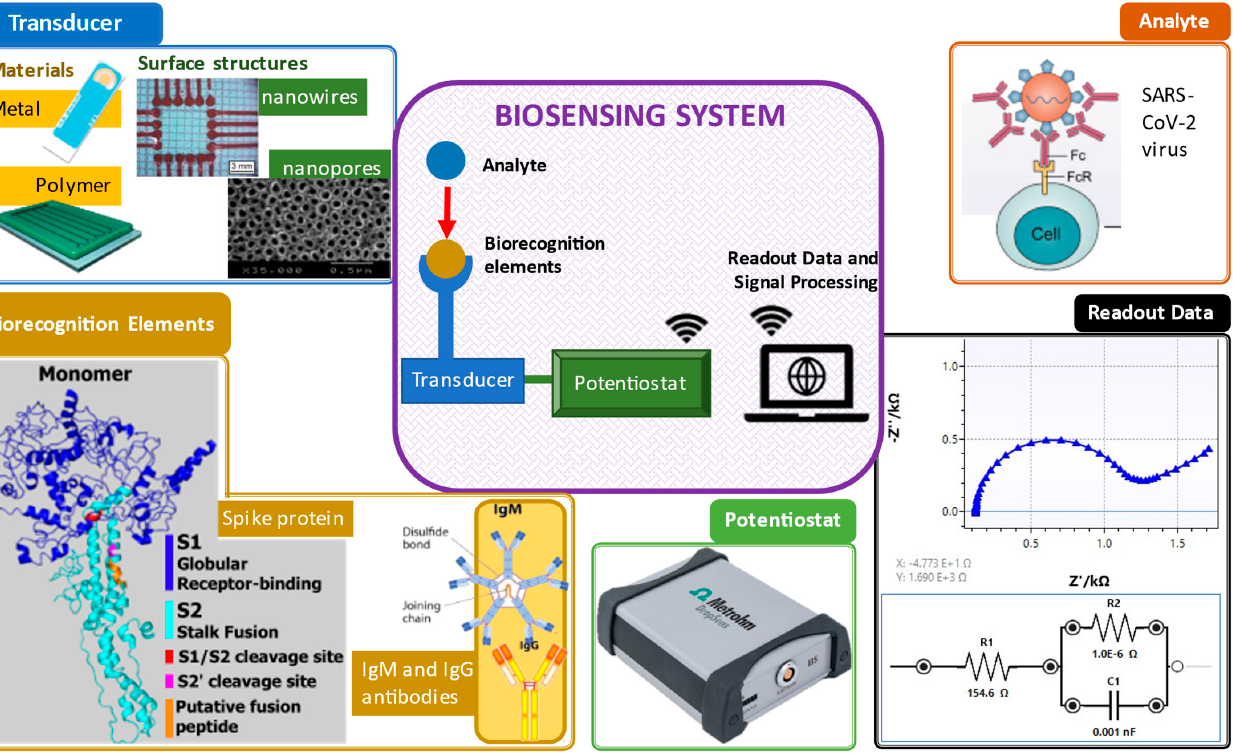
Figure 1. Important elements in a biosensing system. Clockwise from top right: analyte [32], electrochemical impedance spectroscopy readout data, potentiostat [33], biorecognition elements (spike protein [34] and antibodies [35]) and transducers and their surface structures (screen-printed gold electrode [36], polymer electrode [37], nanowire structure [38] and nanopore structure